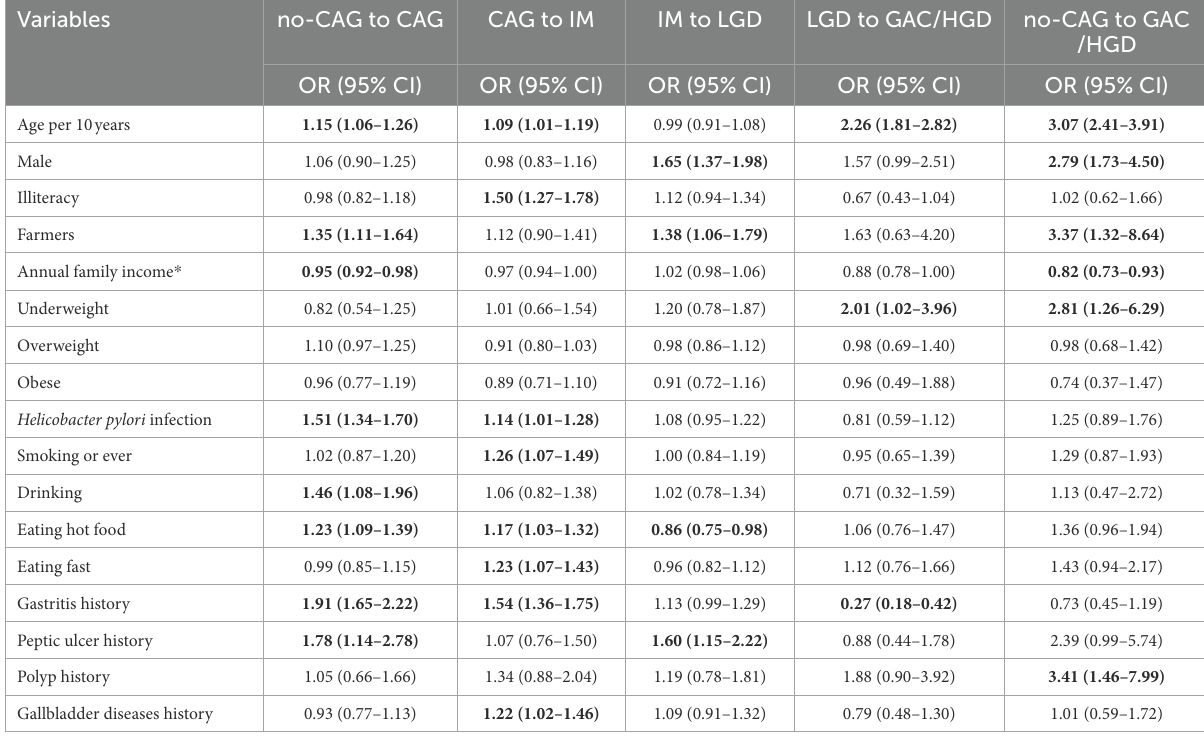
TABLE 2 Effect of varying factors on each